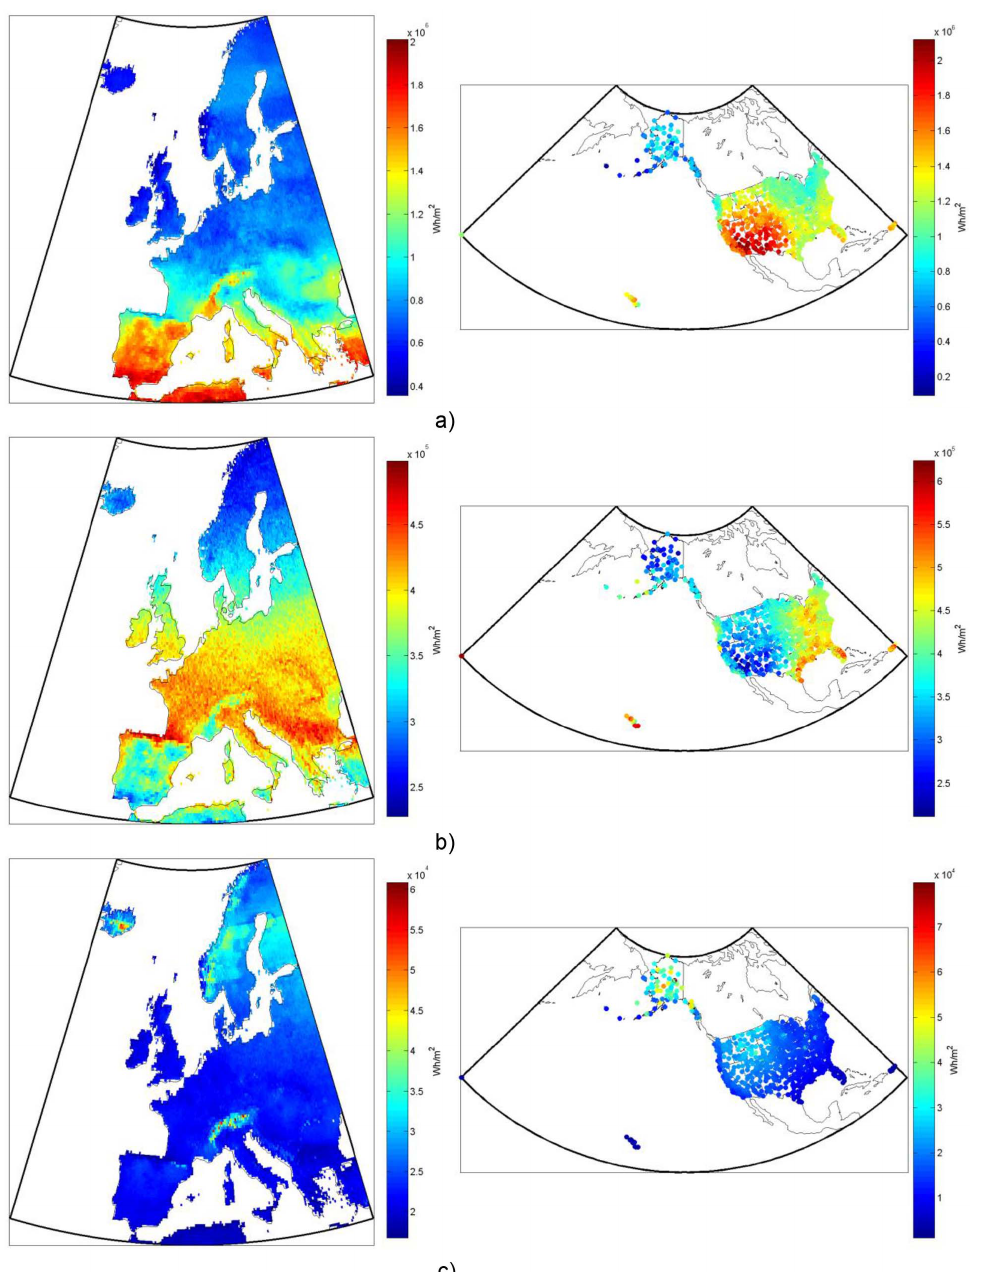
Figure 7. Annual solar irradiance absorbed by one square meter of a non-tracking flat-plate collector tilted at a fixed angle to maximize the yearly total of the three components of radiation: (a) the direct beam and forward scattered circumsolar diffuse component, (b) the non-forward scattered diffuse component, and (c) the ground reflected component. Note that the color scales differ between the subfigures.